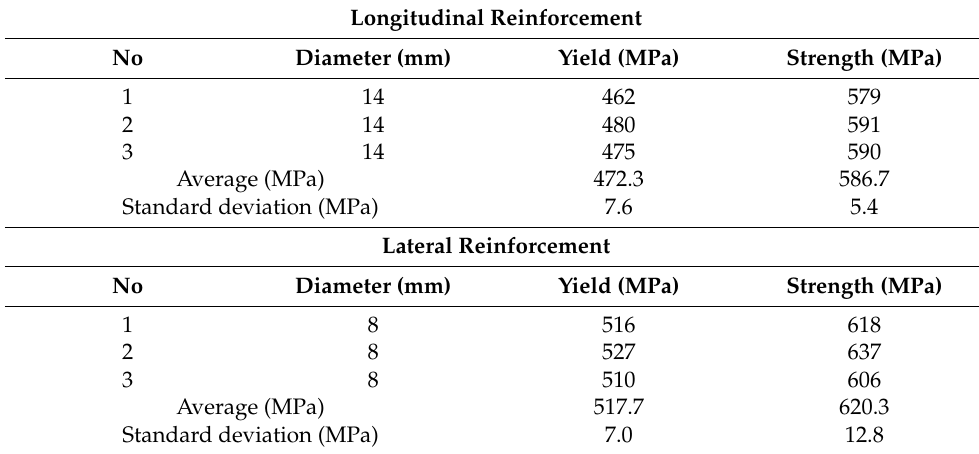
Table 5. Coupon tests for longitudinal and lateral